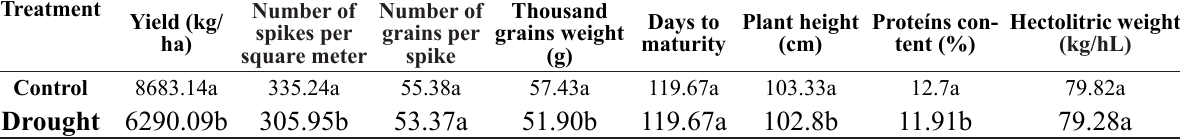
Table 8. Mean values of grain yield, number of spikes per square meter, number of grains per spike, thousand grains weight (g), days to maturity, plant height (cm), protein of grains (%) and hectolitric weight (kg/hL) of the control experiment (complete irrigation) and drought treatment (deficit irrigation) of tolerant wheat genotypes ( Triticum aestivum L.) to drought under conditions of La Molina LM